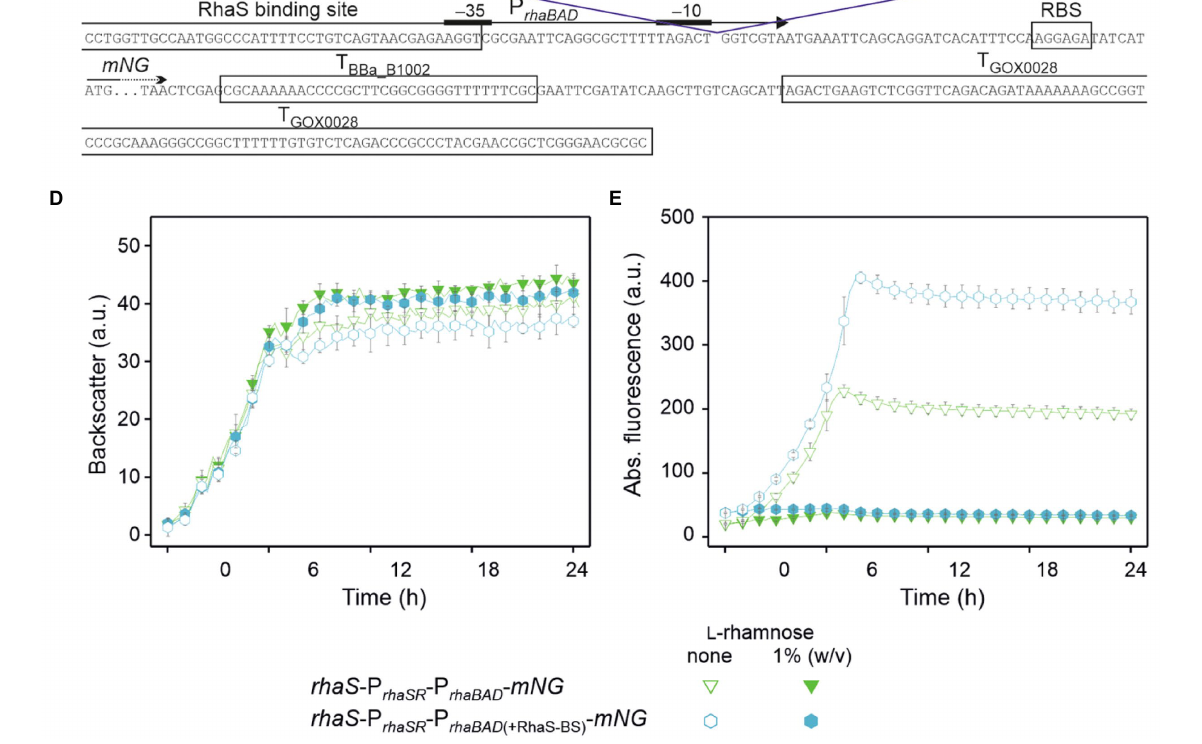
FIGURE 4 Insertion of an additional RhaS binding site downstream from the − 10 region doubled the expression strength of P rhaBAD and the range of repression. (A) Map of plasmid pBBR1MCS-5- rhaS -P rhaSR - P rhaBAD -mNG . (B) Schematic illustration of the pBBR1MCS-5 inserts rhaS -P rhaSR - P rhaBAD - mNG and its variant rhaS -P rhaSR - P rhaBAD (+RhaS-BS) -mNG harboring an additional RhaS binding site directly downstream from the − 10 region, all flanked by terminators. (C) DNA sequence details of the fragment rhaS -P rhaSR -P rhaBAD (+RhaS-BS) - mNG with RhaS and RhaR binding sites as well as terminator sequences adjacent to rhaS and mNG . The promoter elements are given according to Egan and Schleif (1993). (D) Growth according to backscatter and (E) absolute mNG fluorescence of G. oxydans 621H carrying either plasmid pBBR1MCS-5- rhaS -P rhaSR -P rhaBAD - mNG or pBBR1MCS-5- rhaS -P rhaSR -P rhaBAD (+RhaS-BS) - mNG in microscale BioLector cultivations in d -mannitol medium without and with 1% (w/v) l -rhamnose. Data represent mean values and standard deviation from two biological replicates (clones) with three technical replicates each. BioLector settings: backscatter gain 20, fluorescence gain